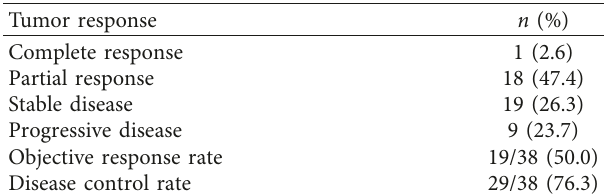
Table 2: Response to combined therapy ( n �